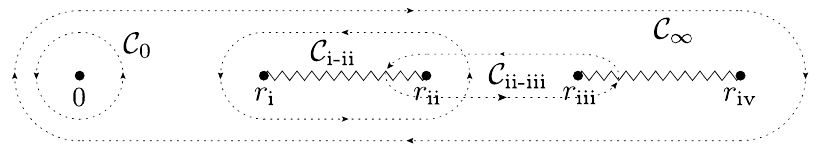
Figure 7 . The four independent contours for the three-mass elliptic